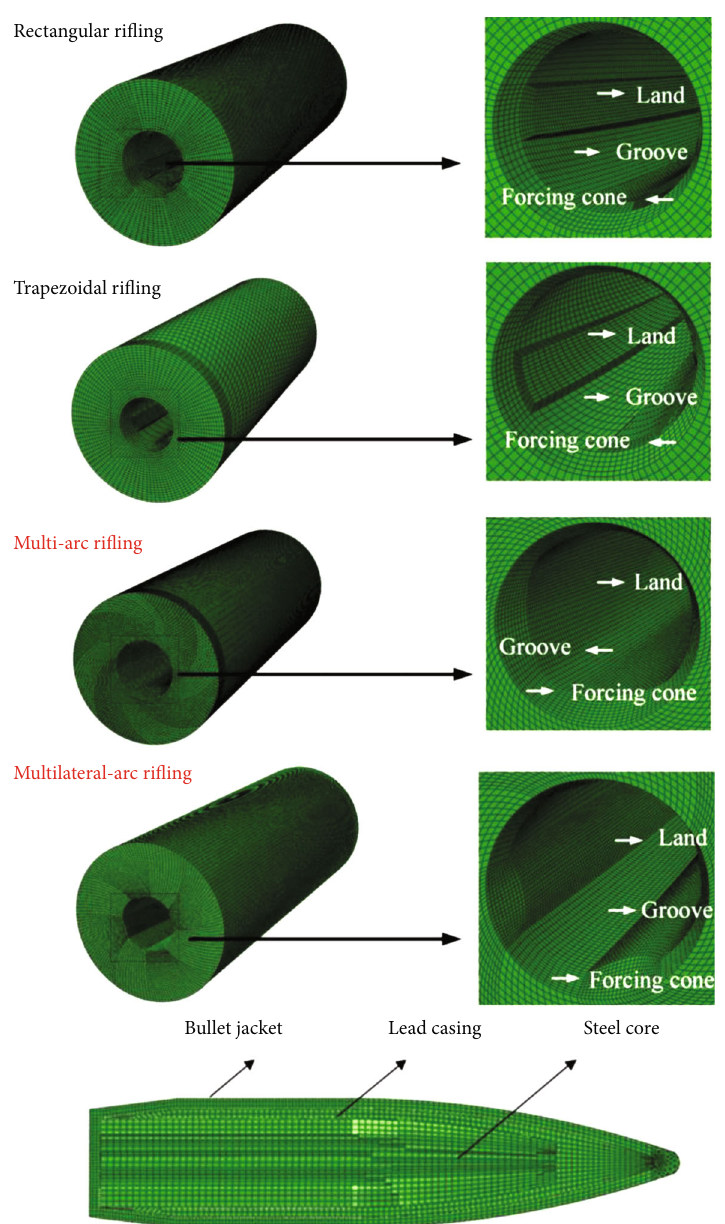
Figure 5: Mesh models of barrels with di ff erent ri fl ing pro fi les and bullets.